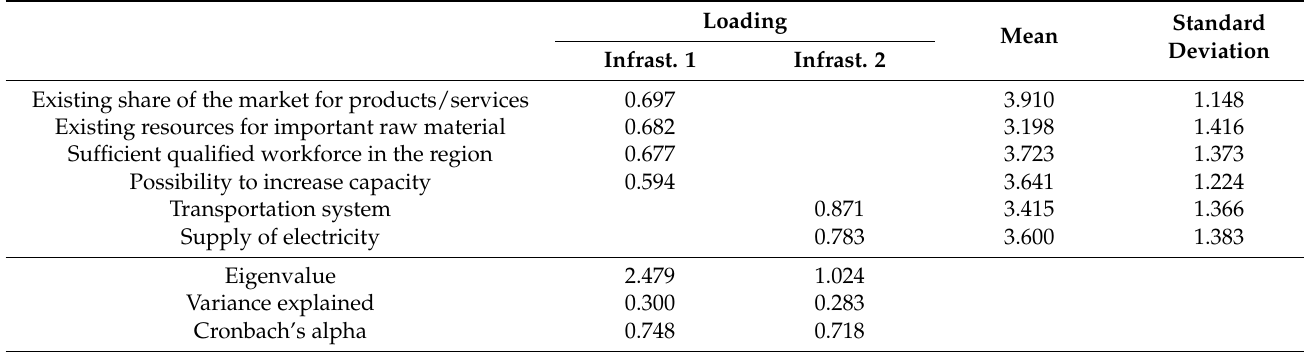
Table 5. Rotated component matrix: